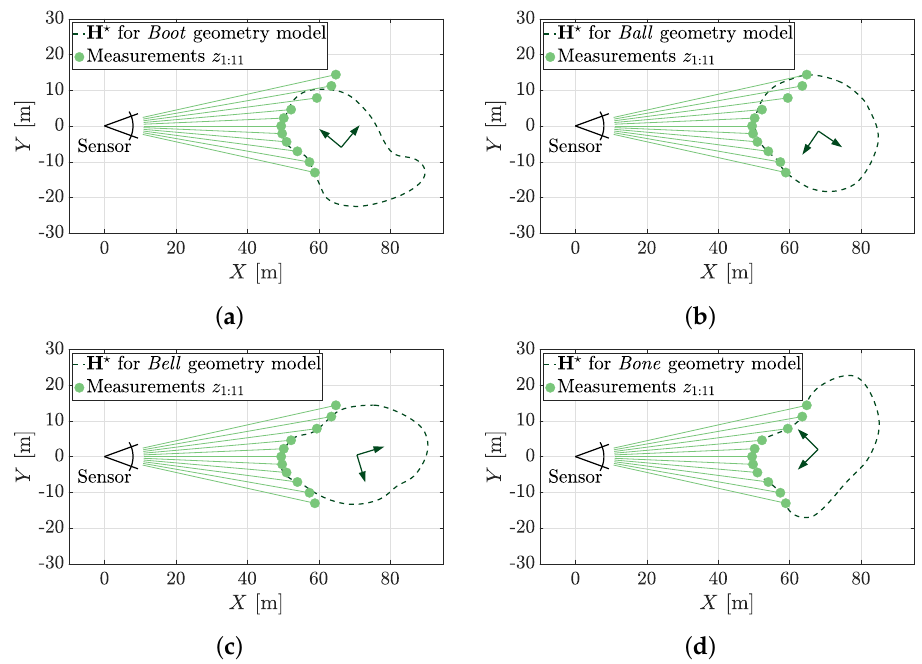
Figure 16. Each geometry is fit to the measurement set using the MSOE algorithm. The maximum sum of evidence measured in these four poses is used to determine which geometry is present in the data. ( a ) The maximum sum of evidence pose of the Boot geometry model. ( b ) The maximum sum of evidence pose of the Ball geometry model. ( c ) The maximum sum of evidence pose of the Bell geometry model. ( d ) The maximum sum of evidence pose of the Bone geometry